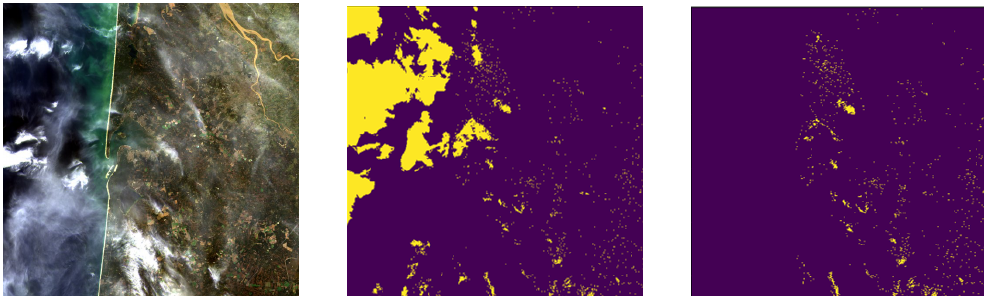
Figure 2. Arcachon scene analysis of the NDWI. The left image represents the original TOA radiance image. The figure in the middle represents the shadow mask before the water correction. The figure on the right represents the shadow mask after the water